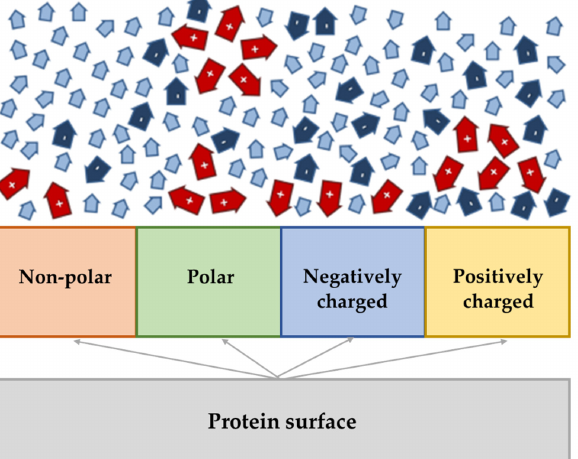
Figure 2. Scheme of the interactions of the dissolved protein in IL-water mixtures. The anions (dark blue arrows) have a preference to the neighborhood of the surface that are positively charged or to the hydration event of water molecules (light blue arrows) in the bulk phase. The cations (red arrows) aggregate in the form of hydrophobic clusters or are pushed to the protein surface. Adapted from reference [19].